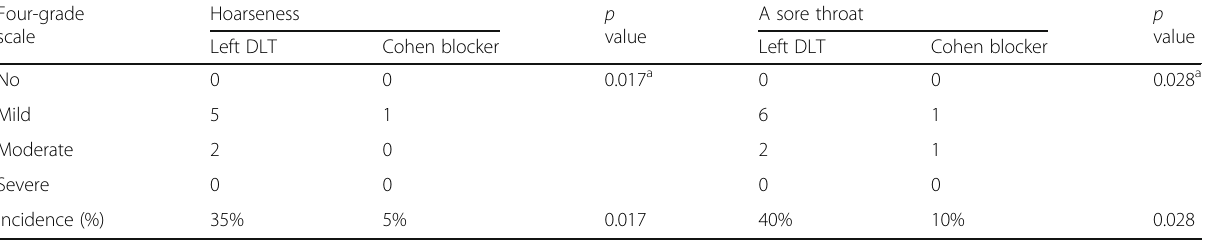
Table 5 Incidence of hoarseness and sore throat Four-grade